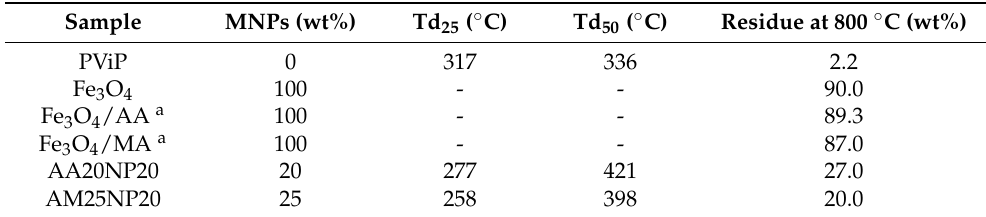
Table 3. Stability of the magnetic nanocomposites: residual material after calcination and decomposi- tion temperatures.